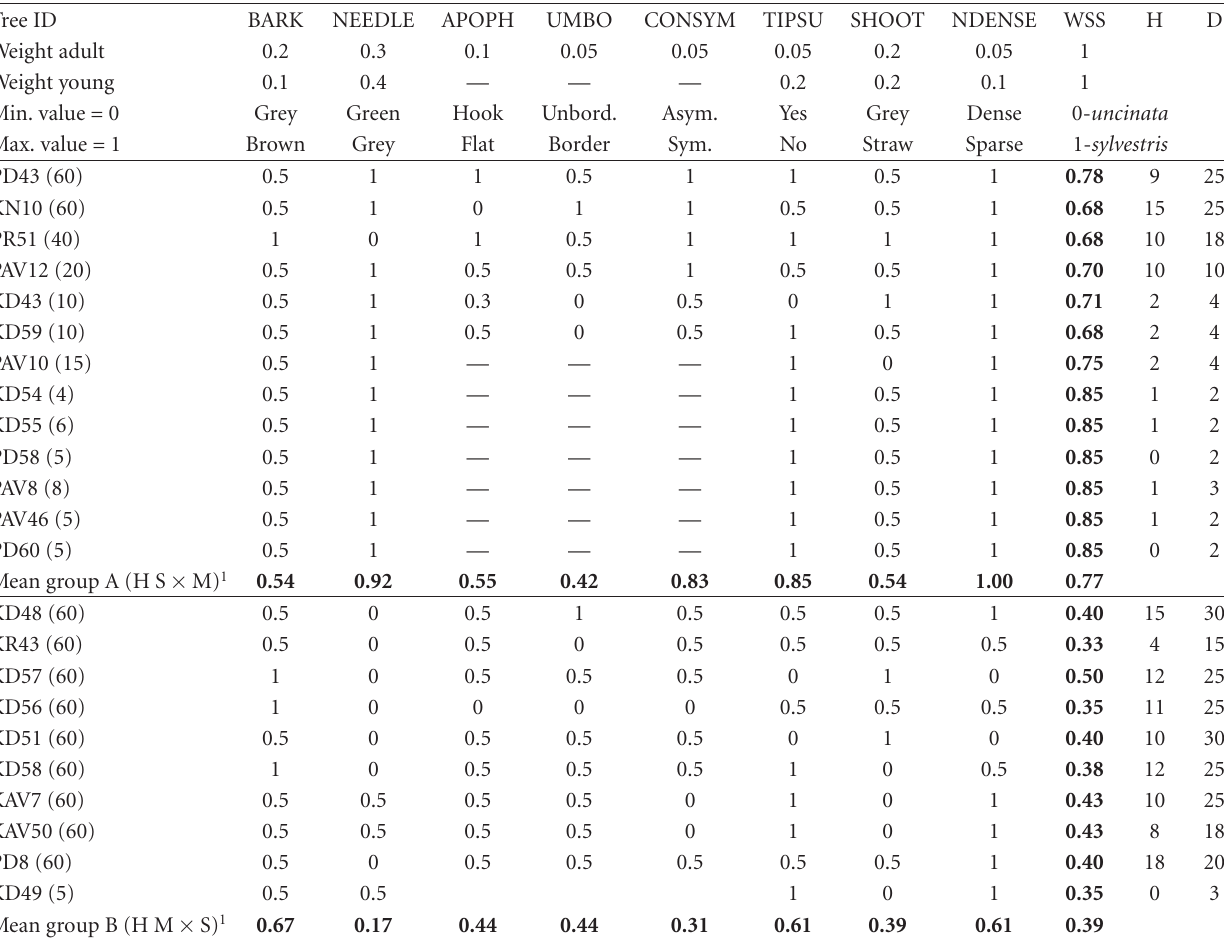
Table 3: Representatives of putative P. sylvestris × P. mugo hybrids grouped into two groups according to the WSS value. The WSS weights sum up to 1. Pure P. sylvestris or P. mugo subsp. uncinata WSS indexes add up to 1 and 0, respectively (based on our observation; not shown). Number at the tree ID indicates the tree age (at least, based on phenotype). Trait abbreviations are explained in Table